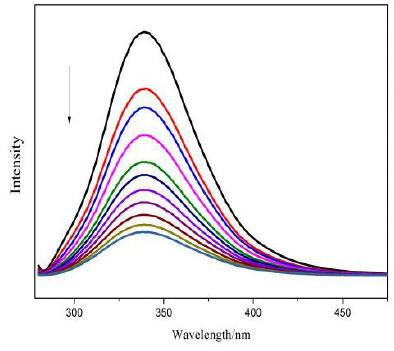
Figure 6. The emission spectra of BSA under di ff erent concentrations of FB. The arrows indicate the